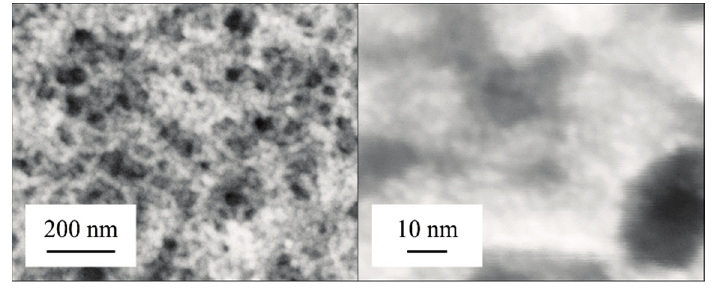
Figure 2. SEM pictures of platinum nanoparticles stabilized by organic ligands. The pictures illustrate the high porosity and surface. On the hand right picture, particles can be seen. Average particle size is 1.8 nm (with permission from